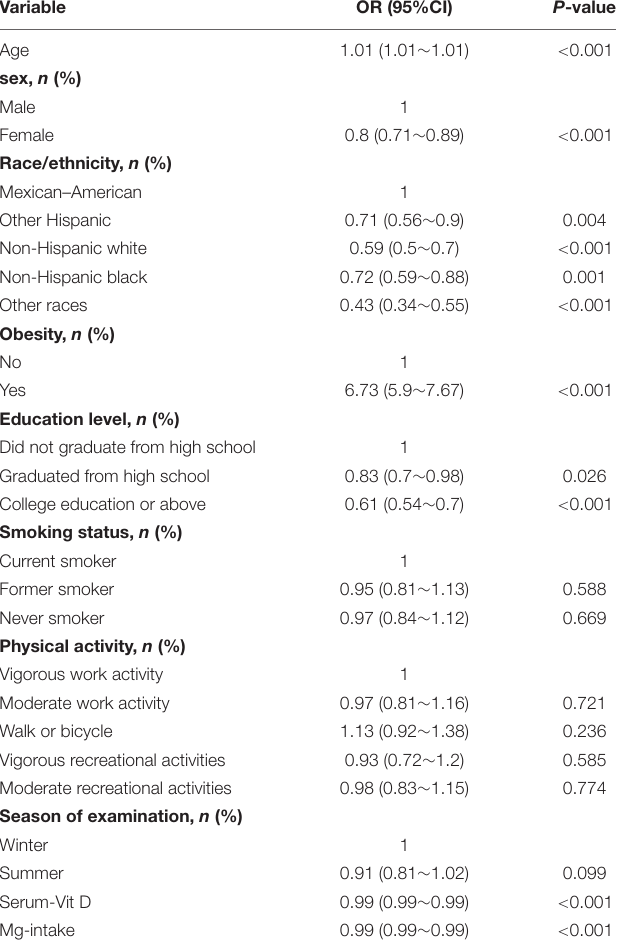
TABLE 2 | Association of covariates and